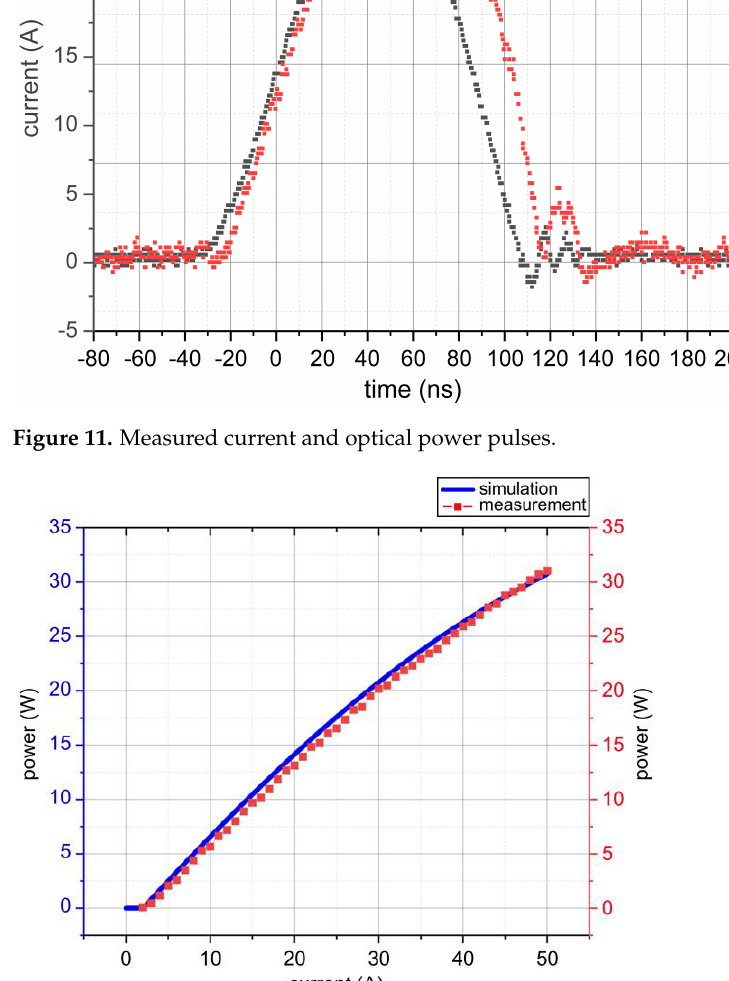
Figure 11. Measured current and optical power pulses.